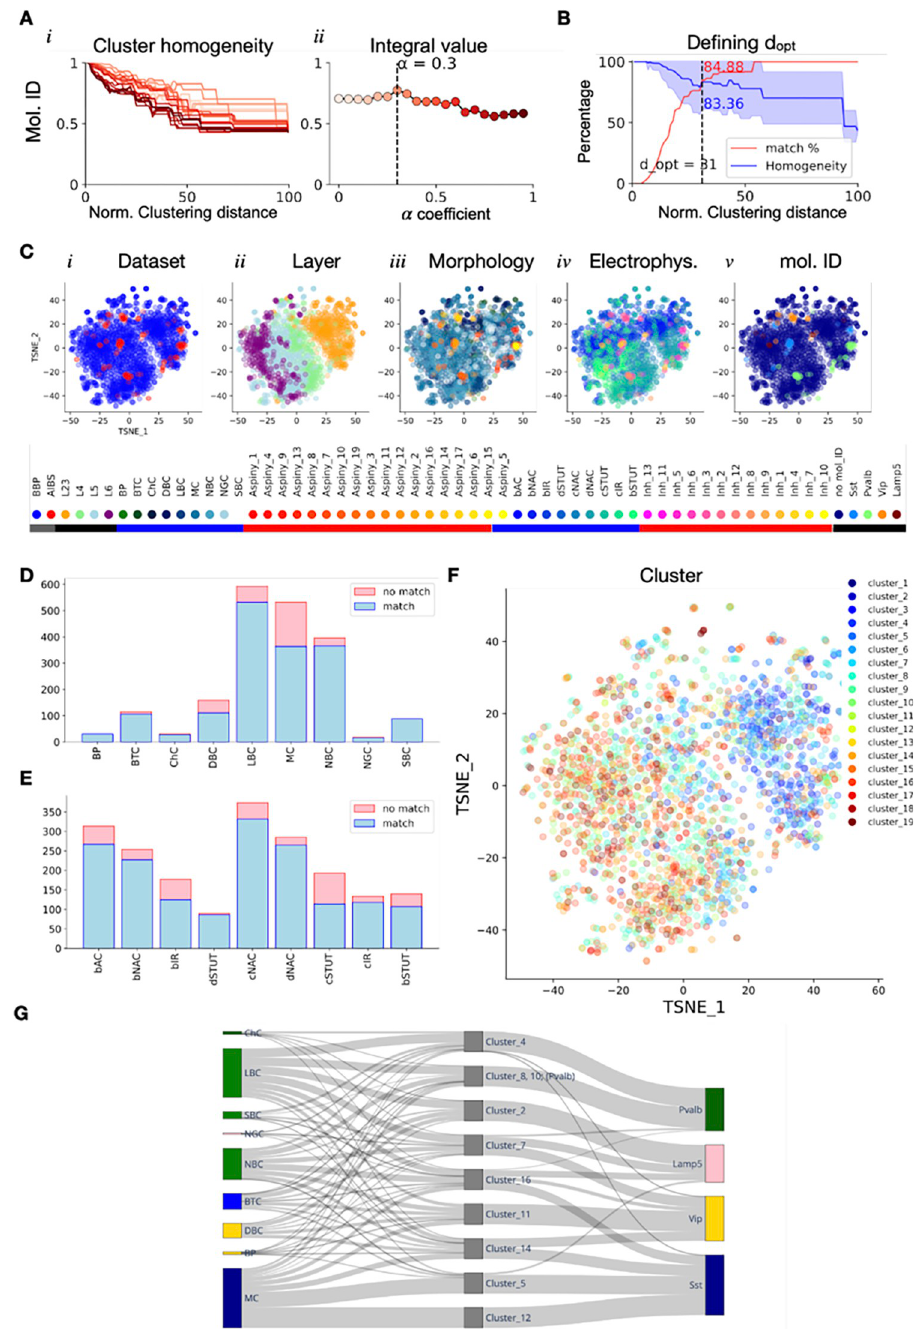
Fig 4. Forming common clusters merging rat (BBP) and mouse (AIBS) cells. A. optimization of α value using molecular ID labels for AIBS dataset. B. Optimal clustering distance is computed by compromising between cluster average homogeneity using marker labelling system (blue, mean +/- standard dev.) and maximizing the percentage of matched cells (red). C. T-SNE visualization of the optimized common subspace, data points color coded by dataset, layer labels, dataset native morphological labels, dataset native electrical labels and molecular ID. Colored bars under the legend delineate AIBS native labels (red) from BBP native labels (blue). Labels used for both datasets are underlined in black or grey. Note that the points colored in dark blue on v are BBP cells for which we have no molecular ID labels. D. Portion of matched BBP cells grouped per BBP m-types and ( E ) e-types. F. T-SNE visualization of the optimized common subspace, data points color coded by common clusters. G. River plot showing the distribution of BBP m- types (left) and AIBS molecular IDs (right) in each common cluster (center). Clusters that mapped to one marker